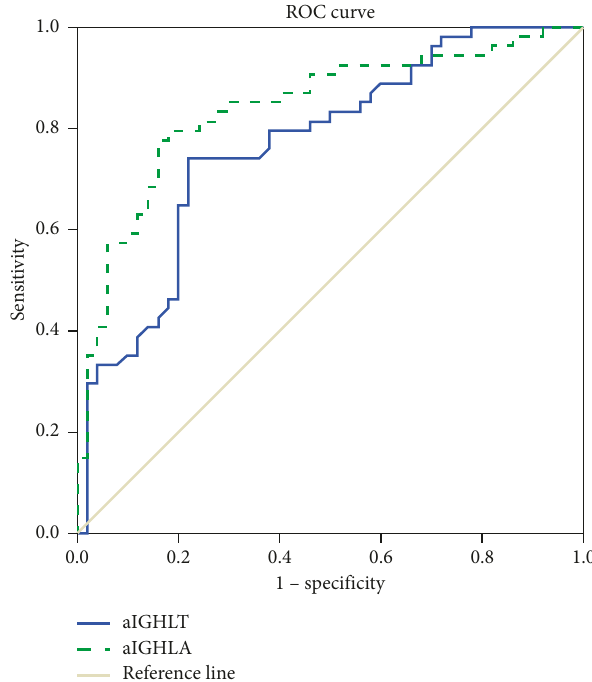
Figure 2: Receiver operating characteristic (ROC) curve of anterior band of inferior glenohumeral ligament thickness (aIGHLT) and anterior band of inferior glenohumeral ligament area (aIGHLA) for prediction of adhesive capsulitis. The best cut off point of aIGHLA was 63.37mm 2 versus 3.81 mm of aIGHLT, with sensitivity 79.6% versus 74.1%, specificity 80.0% versus 74.0% and AUC 0.84 versus 0.77, respectively. aIGHLT AUC (95% CI) � 0.77 (0.68–0.86). aIGHLA AUC (95% CI) � 0.84 (0.76–0.92). AUC � area under the curve. Table 2: Sensitivity and specificity of each cut-off point of the aIGHLT.